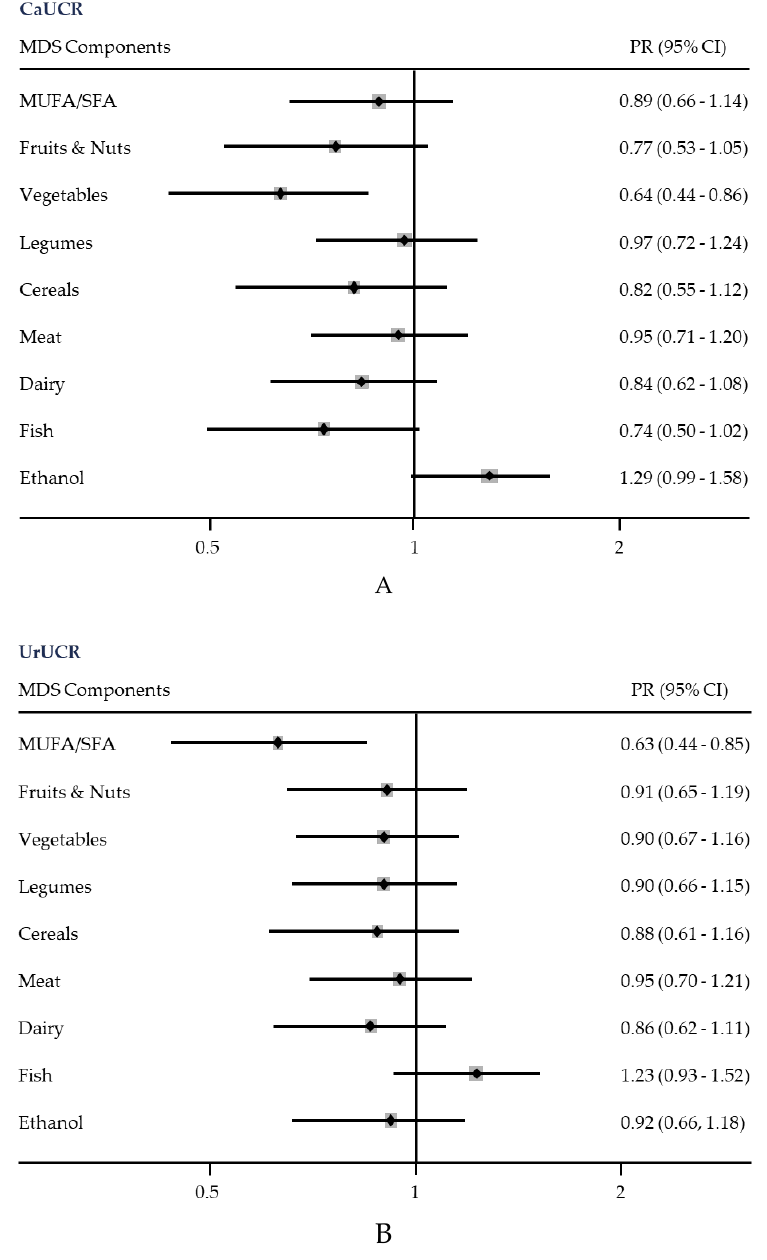
Figure 2. Prevalence ratios (95% CIs) of high calcium urinary crystallization risk (CaUCR) ( A ) and high uric acid urinary crystallization risk (UrUCR) ( B ) with individual components of the Mediterranean diet score (MDS) [15]. Binary logistic regression adjusted for age, sex, type 2 diabetes, body mass index, and energy intake. Each subject received a score of 0 or 1 for each of the nine dietary components (MUFA, mono-unsaturated fatty acid; SFA, saturated fatty acid).